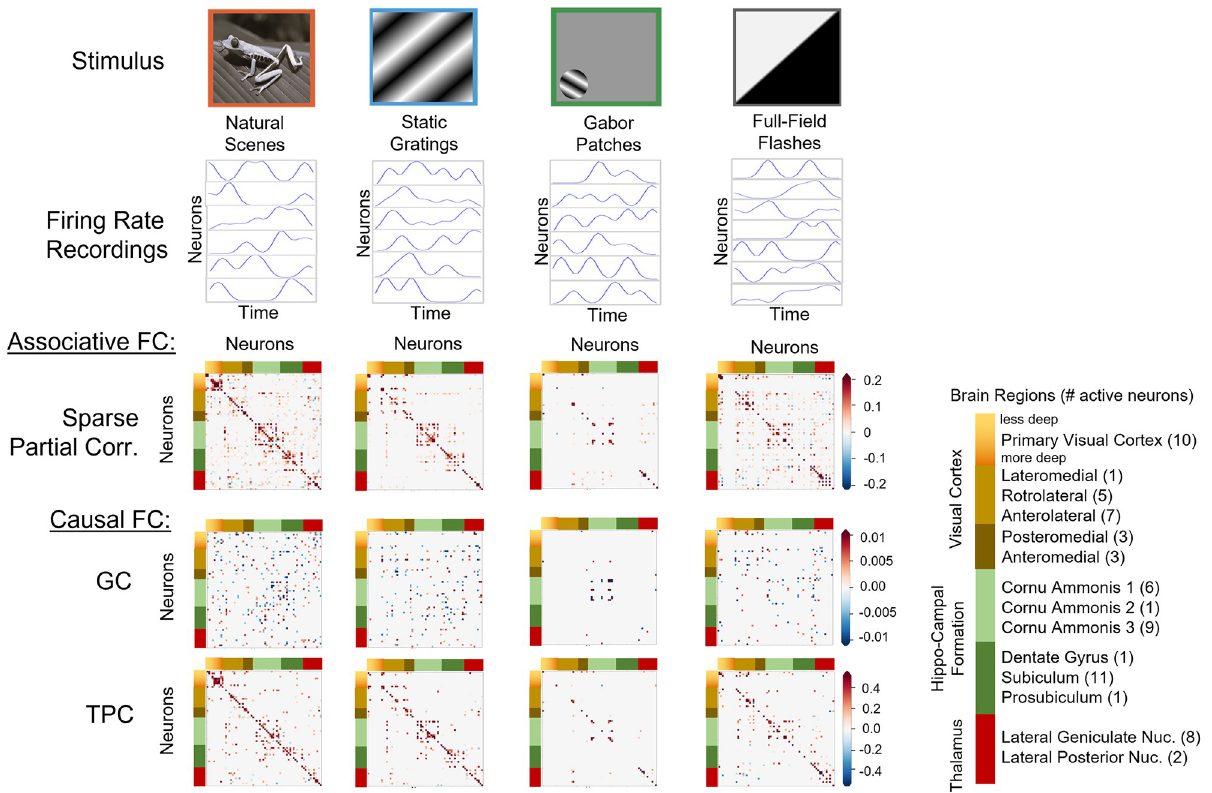
Fig 6. Application to Neuropixels dataset. Comparison and demonstration of the FC inferred for a benchmark of mice brain data from the Allen Institute’s Neuropixels dataset, by three methods for FC inference: Associative FC using Sparse Partial Correlation, and Causal FC using GC and TPC. The estimated FC is represented by its adjacency matrix with edge weights, which is symmetric for Associative FC and asymmetric for Causal FC. The mice were subject to different stimuli, among which we selected four stimuli categories with distinct characteristics: Natural Scenes, Static Gratings, Gabor Patches and Full-Field Flashes [43]. The neurons are clustered by the region of brain: Visual Cortex, Hippo-Campal Formation, and Thalamus, which are further divided into sub-regions. In the adjacency matrices, a non-zero entry in ( i , j ) represents the connection of neuron i ! j